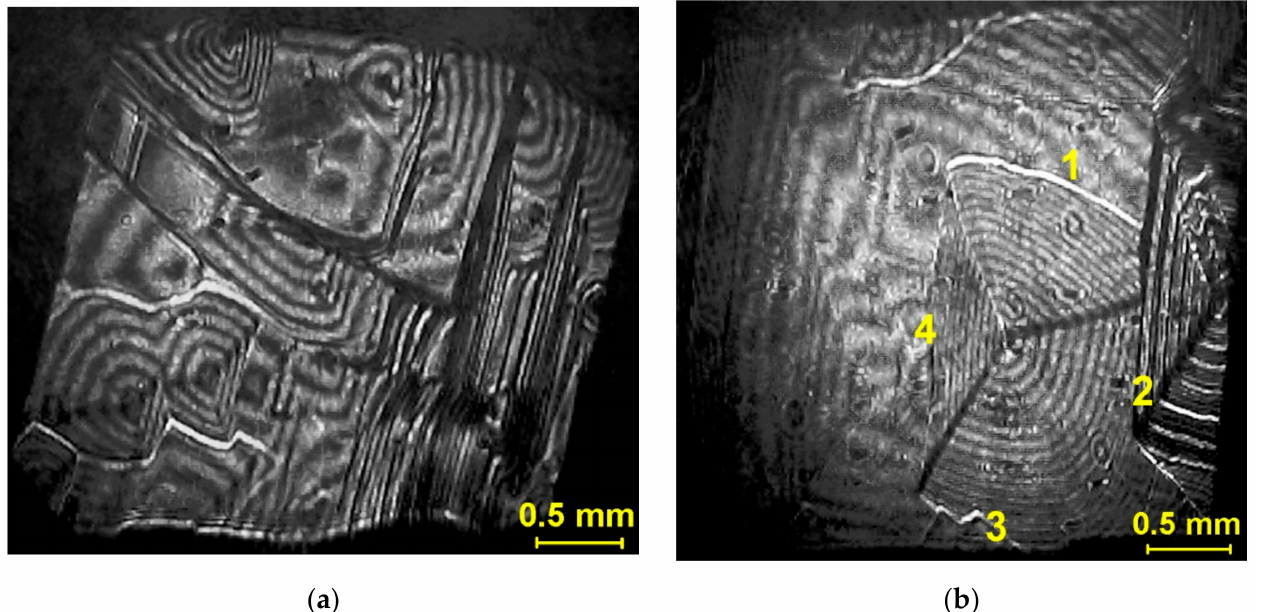
Figure 1. Fringe patterns (interferograms) of the (110) faces of different seed crystals in 1:1 solution: ( a ) regeneration stage, σ = 0.009; ( b ) regular surface growing at σ = 0.013.